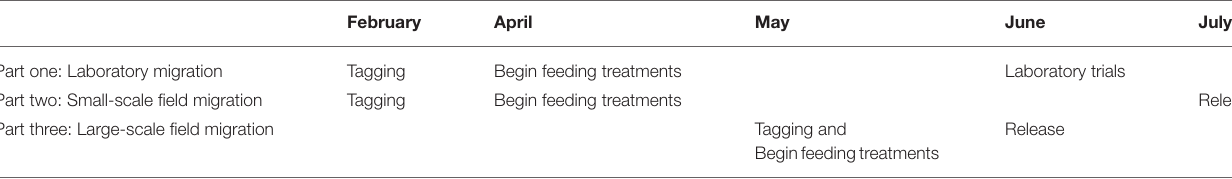
TABLE 1 | A timeline detailing when each part of the study was conducted over the winter/spring of 2017.